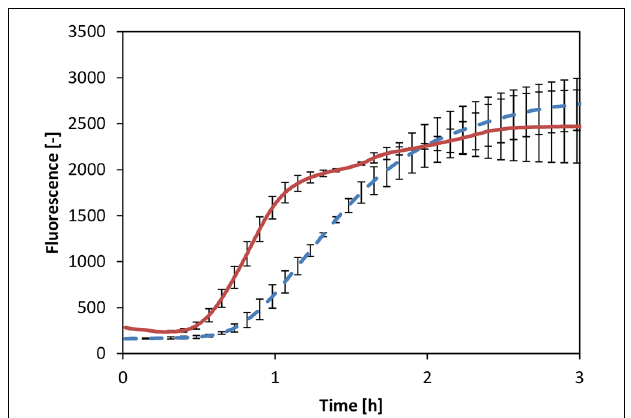
FIGURE 5 | CFPS with T7 RNAP (dotted line) and core RNAP (solid line). Error bars represent standard deviations of triplicate